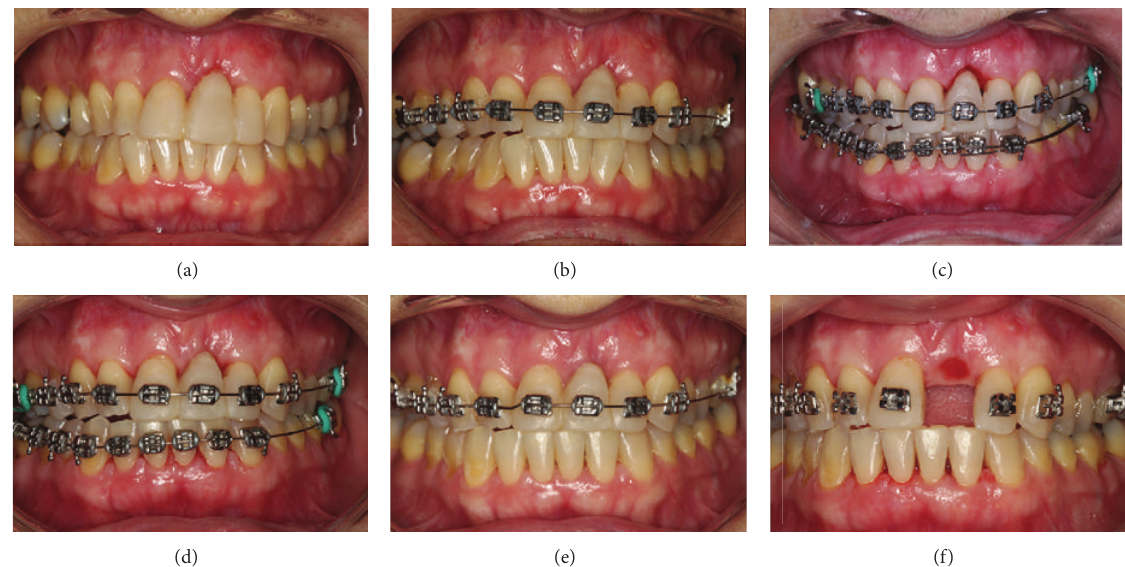
Figure 5: Orthodontic movement progress showing coronal gingival displacement favoring the aesthetic results after 13 months of active orthodontic movement by means of alignment and leveling.